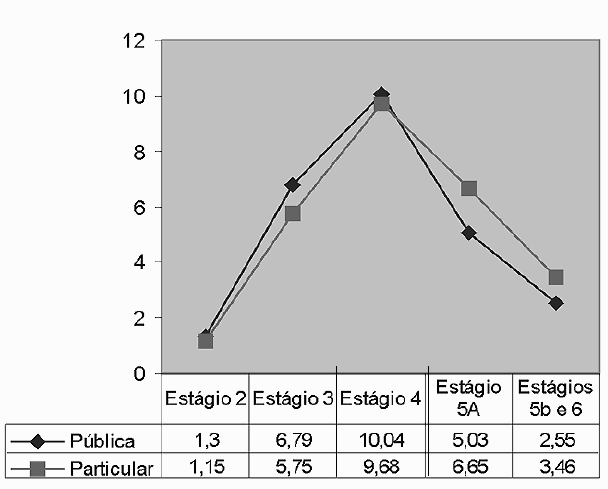
Figura 1. Pontua(cid:231)ªo mØdia bruta dos jovens brasileiros de escola pœblica e particular no DIT-1.